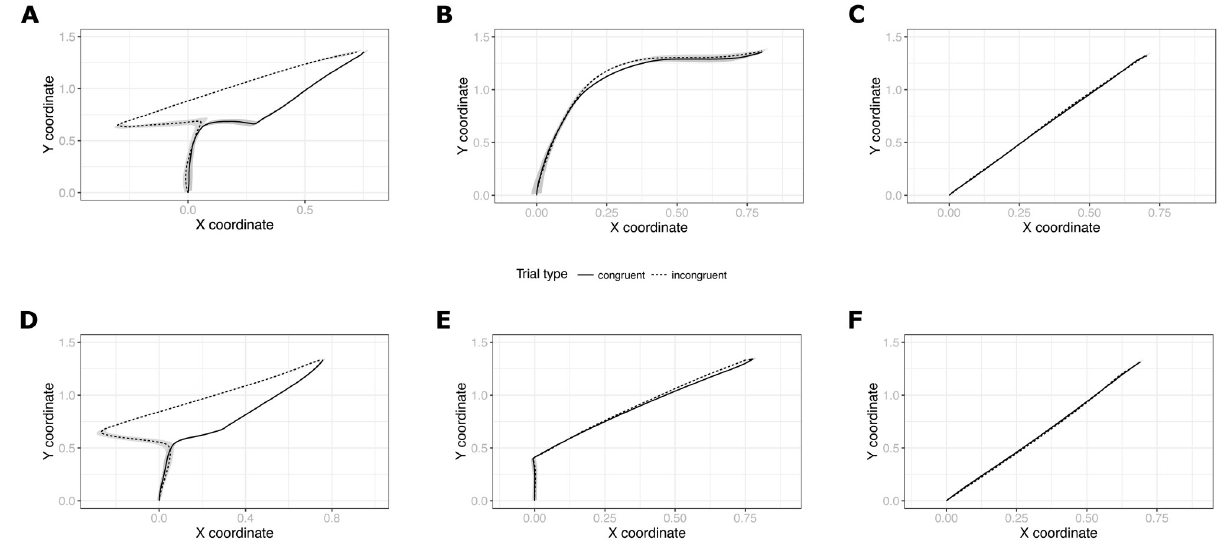
Fig 8. Example average individual movement trajectories in active trials in Experiment 3 (A-C) and 2 (D-F). Plots A and D show curved participants with a detectable Simon effect. Plots B and E show curved participants without a detectable Simon effect. Plots C and F show straight participants without a detectable Simon